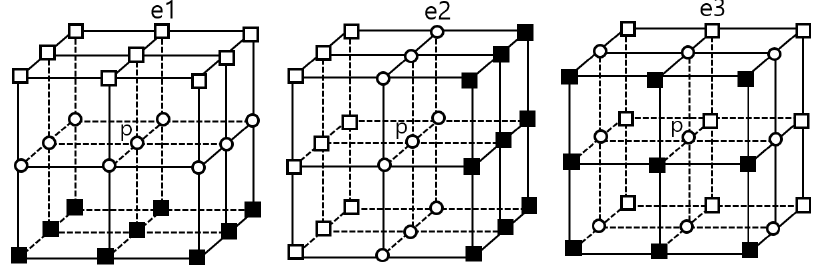
Figure 8. Correcting templates of class E.